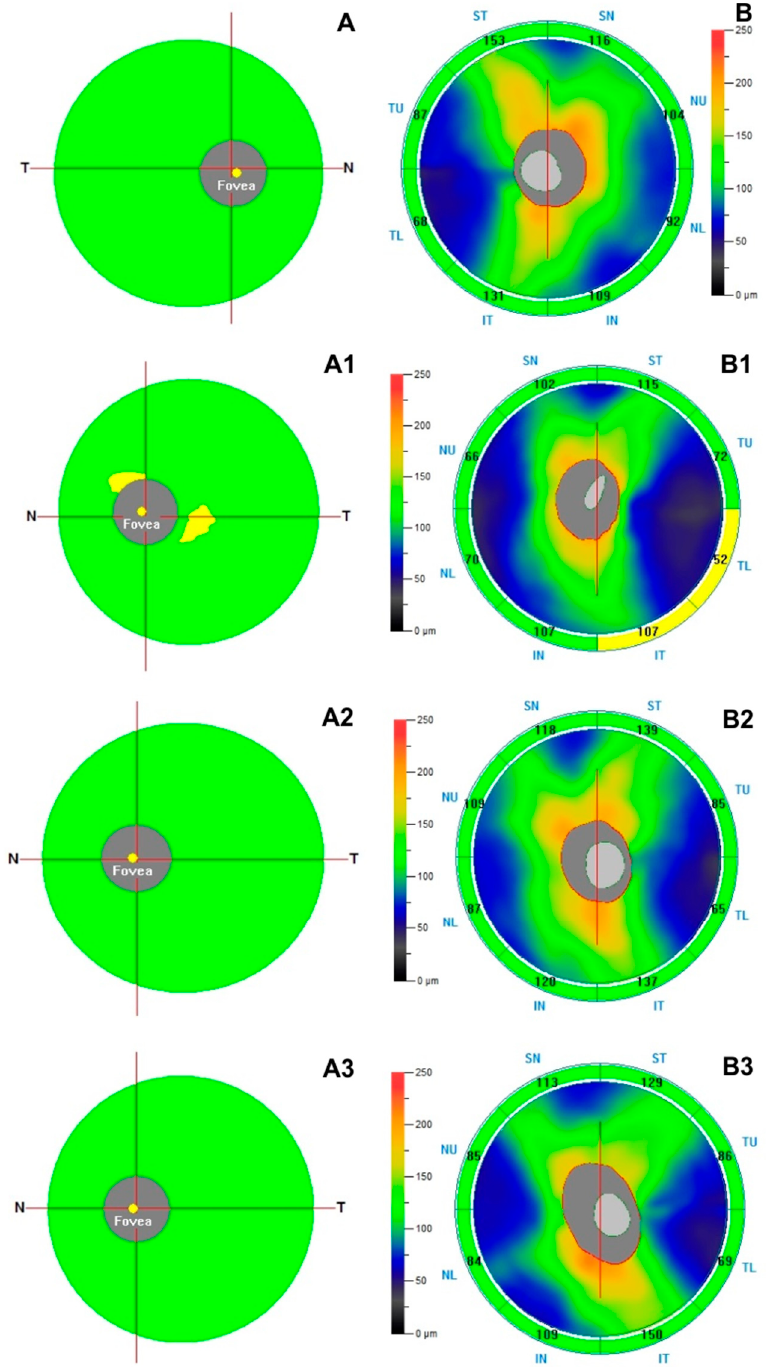
Figure 1. Top Row—Right eye of a 44 years-old male healthy subject shows normal thickness in Ganglion Cell Complex (GCC) ( A ) and in Retinal Nerve Fiber Layer (RNFL) ( B ) at structural spectral domain-optical coherence tomography (SD-OCT). Second Row—Left eye of a 43 years-old female patient with Transfusion Dependent Thalassemia shows focal reduction in GCC and RNFL thicknesses at SD-OCT ( A1 , B1 ). Third Row—Left eye of a 45 years-old female patient with Non- Transfusion Dependent Thalassemia shows absence of changes in GCC ( A2 ) and RNFL ( B2 ). Bottom Row–Left eye of a 44 years-old male patient with β -thalassemia minor shows absence of changes in GCC ( A3 ) and RNFL ( B3 ).